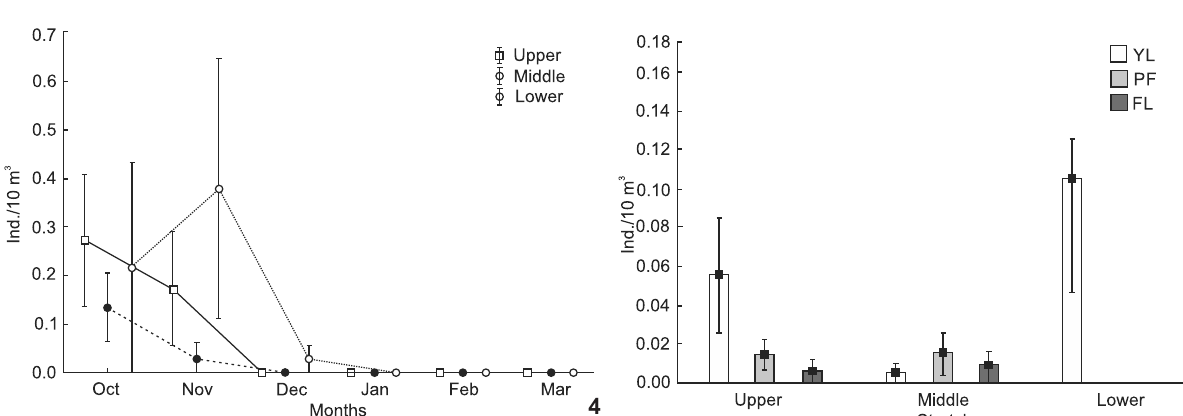
Figures 4-5. Spatial and temporal variation (4) in the mean density of Salminus brasiliensis and of development stages (5) (YL: yolk-sac, PF: preflexion, FL: flexion) in the region of Ilha Grande National Park, in Paraná River.